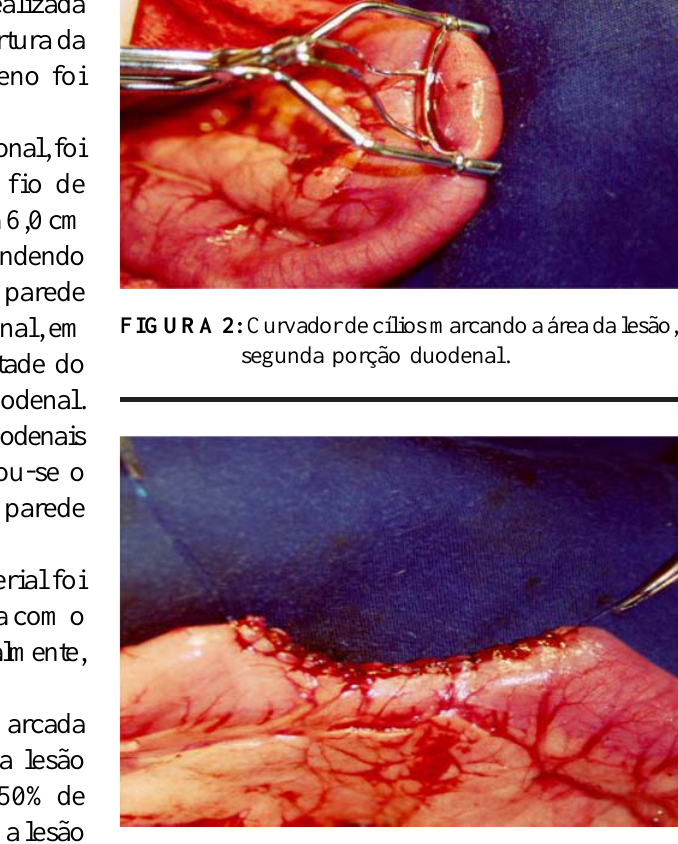
FIGURA 3: Estenose duodenal, após